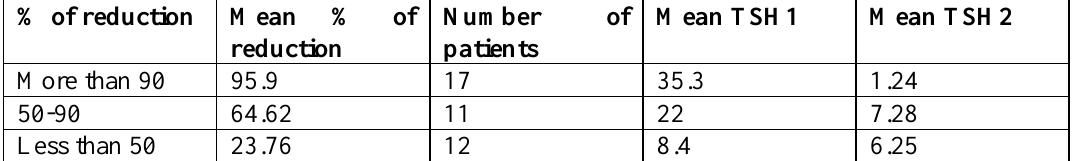
Table 6: TSH status after metformin and percentage of reduction.